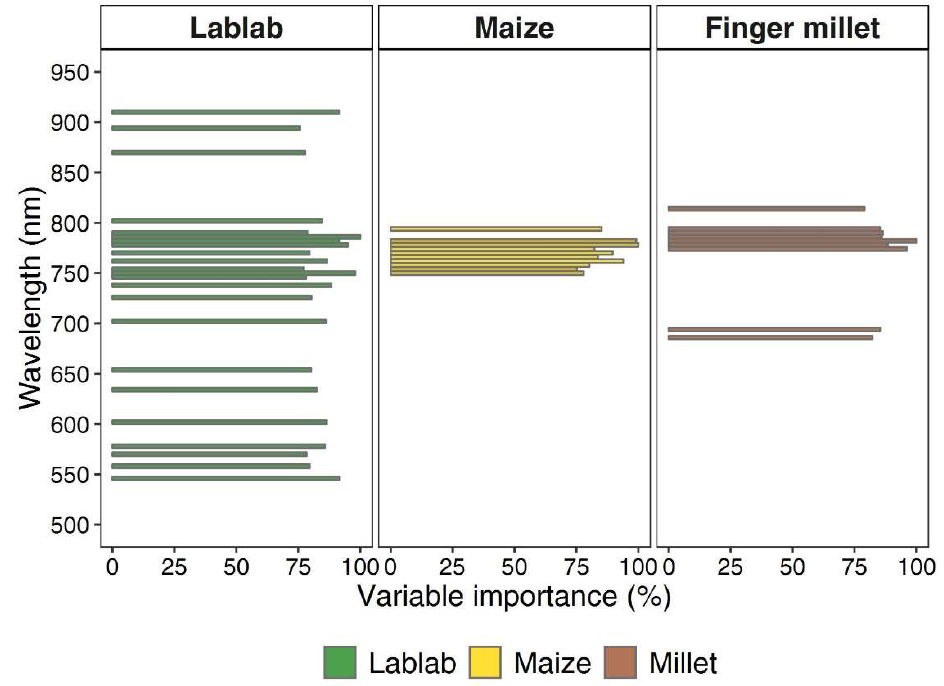
Figure 10. Important wavelengths (score above 75) in the Generalised models for fresh matter biomass of lablab, maize and finger millet. Models were built on data from three different years, three levels of N and two levels of water supply (i.e., rainfed and